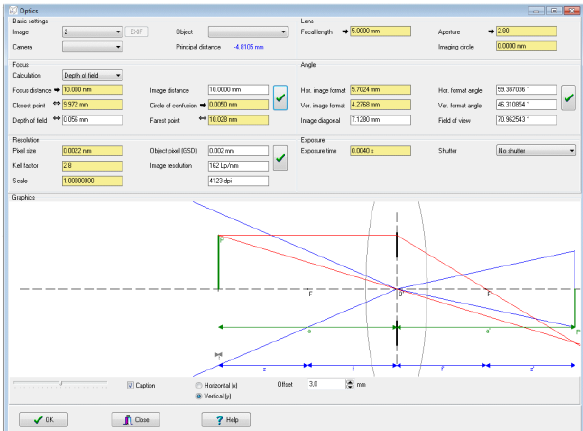
Figure 9: Calculation and display of optical